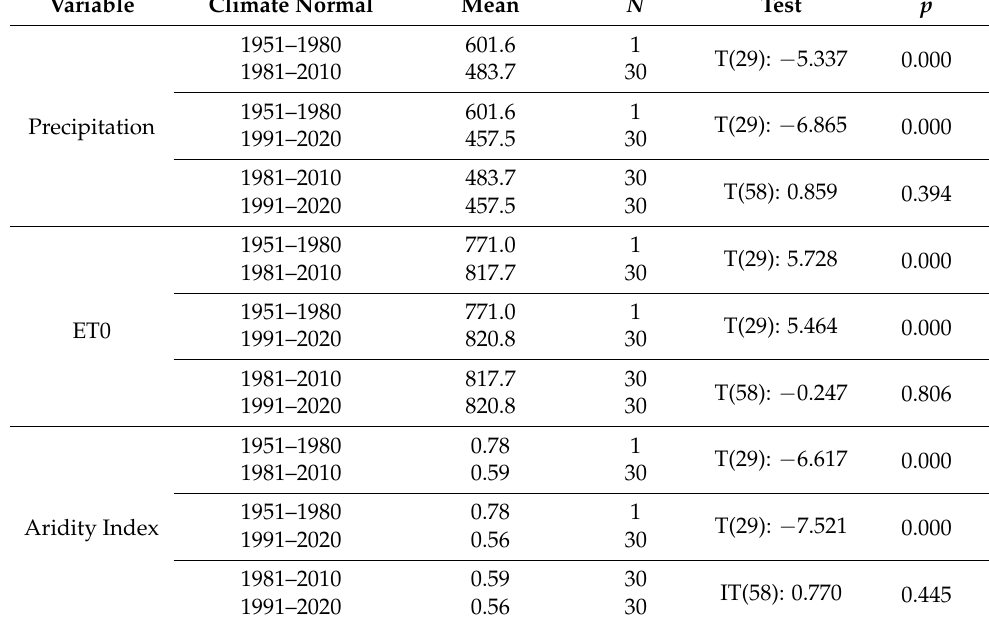
Table 4. Precipitation, ET0 and aridity index comparisons between climate normals.